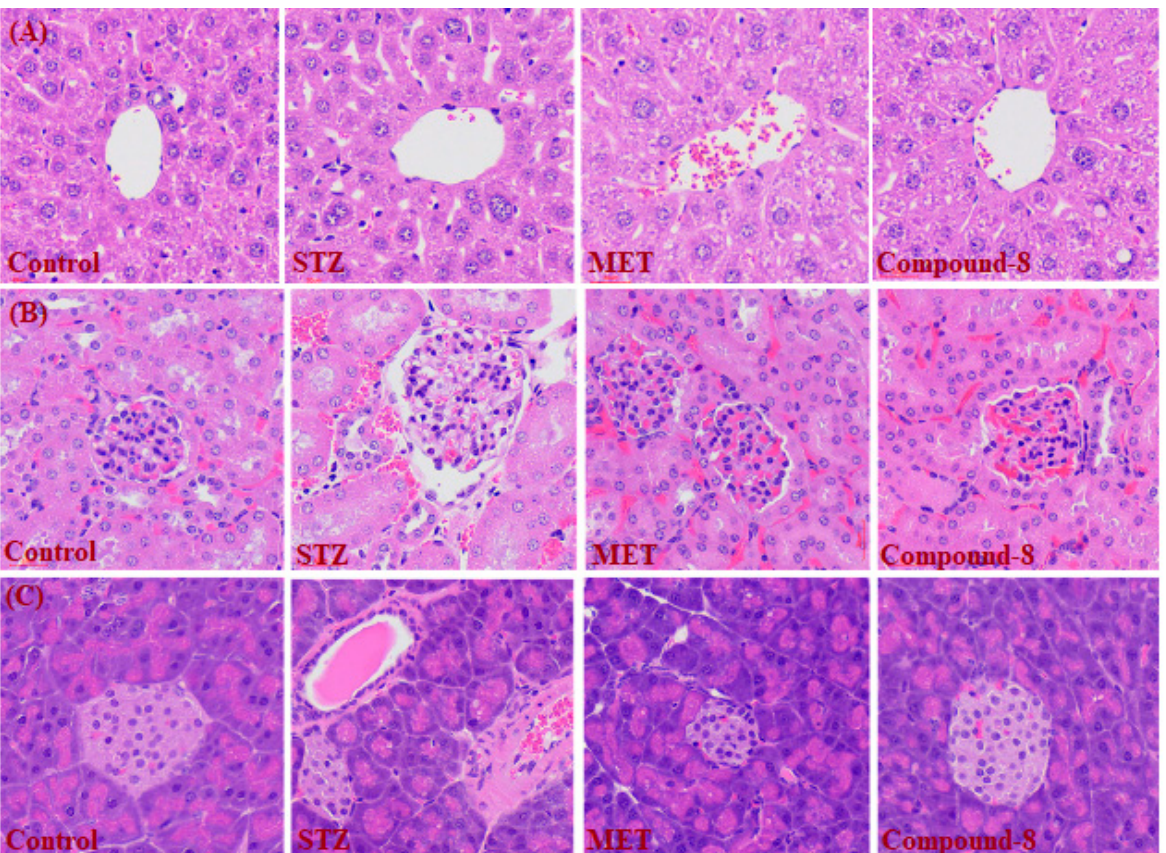
Figure 4. Effect of the tested synthesized compound treatments on histology of the liver ( A ), kidneys ( B ), and pancreas ( C ) of diabetic mice.